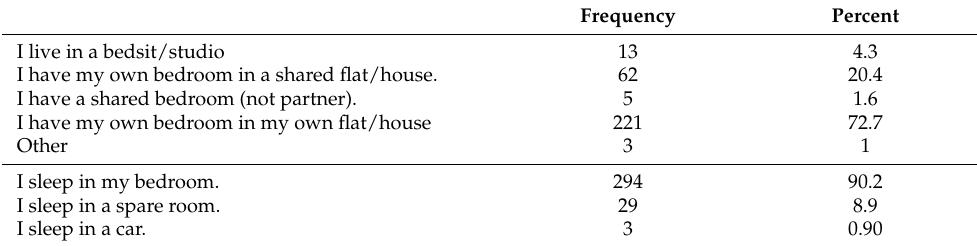
Table 5. Questions related to sleep environment and its location.